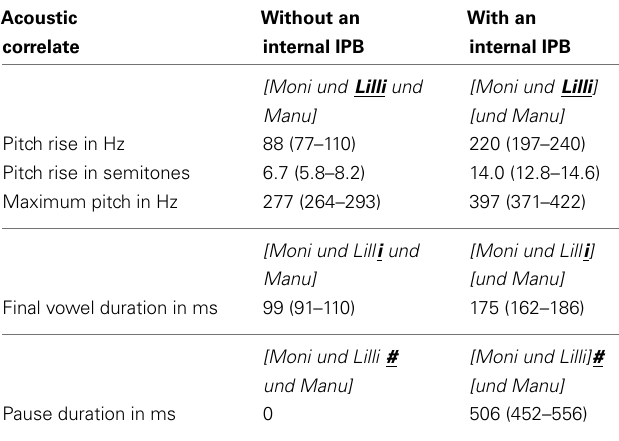
Table 1 | Mean values and range of the acoustic correlates of prosodic boundary cues in the experimental